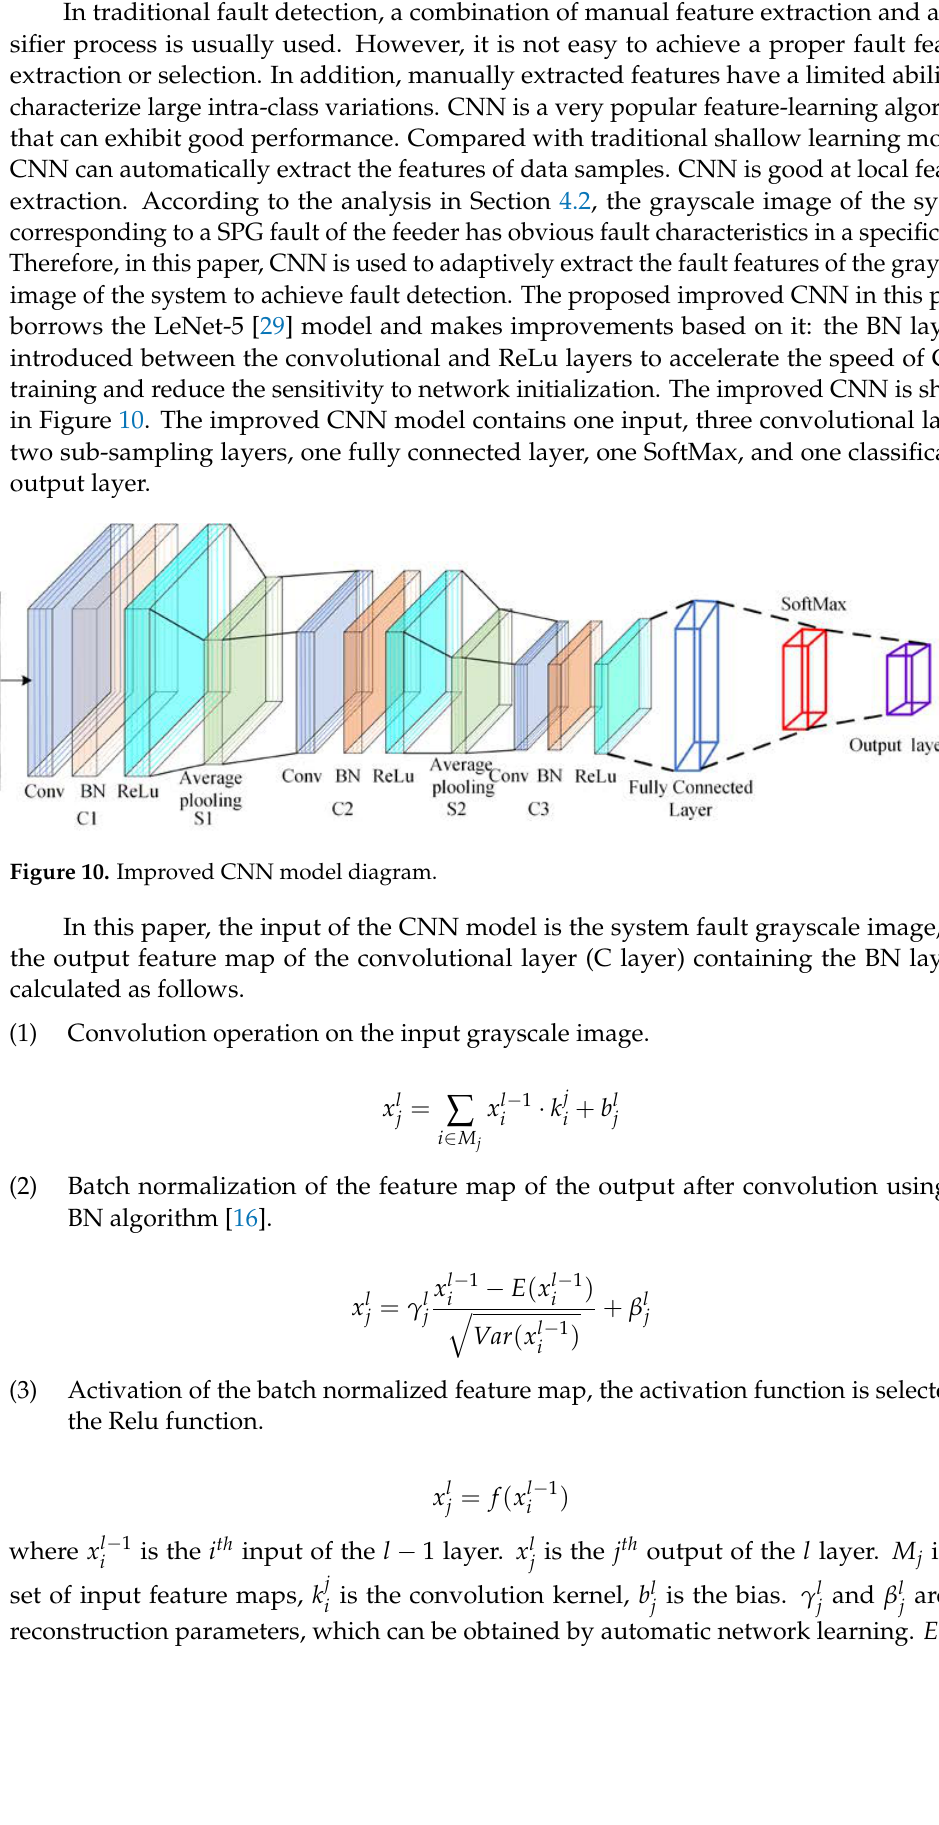
10 of 20 Figure 9. Grayscale images of the system with different feeder faults. To sum up, when SPG fault occurs in the distribution network system, the color of